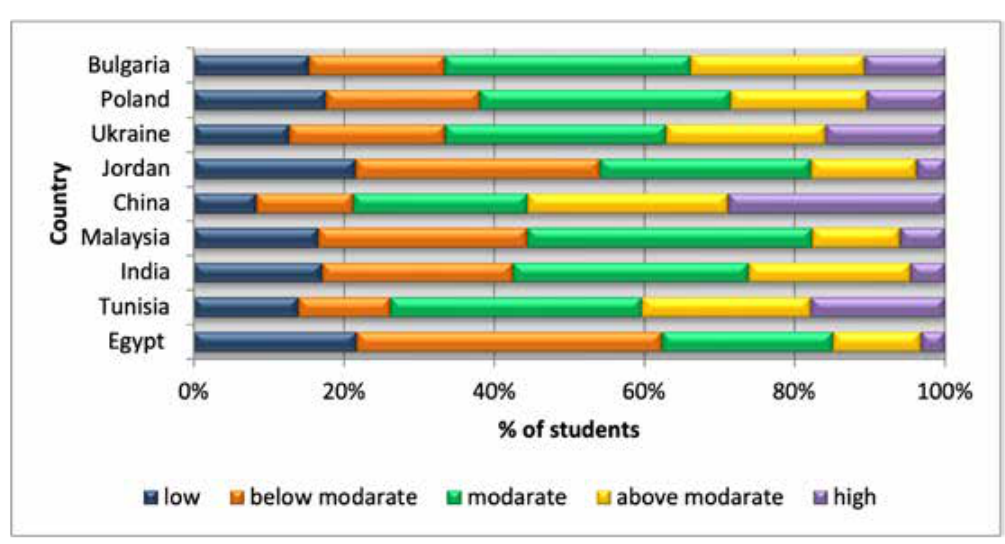
Figure 5. Distribution by levels of dexterity preparation of students